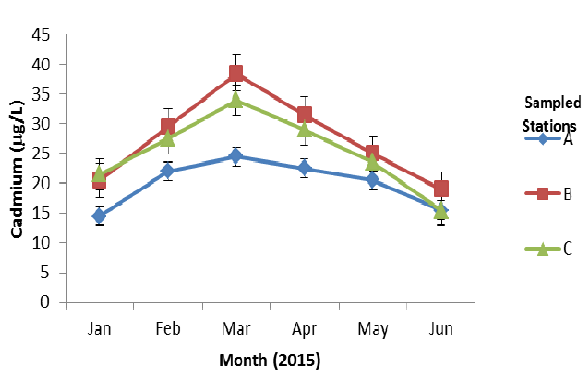
Fig. 13. The monthly mean variation in the cadmium (mg/L) levels of the water sampled from Saba River